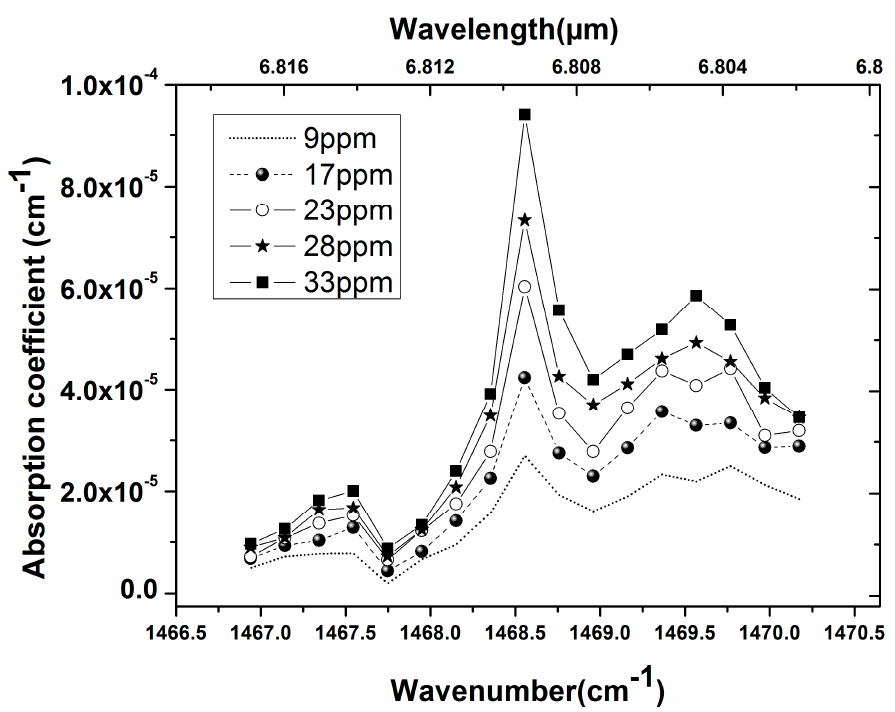
Figure 6. Absorption spectra of different concentrations of ammonia from 9 to 33 ppm at a pressure of 0.4 Atm.